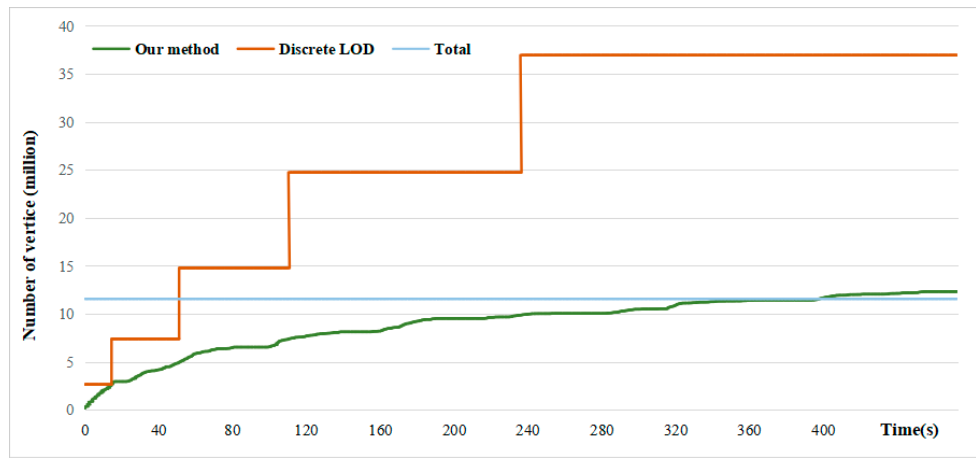
Figure 16. Vertex data volume statistics of the urban scene.